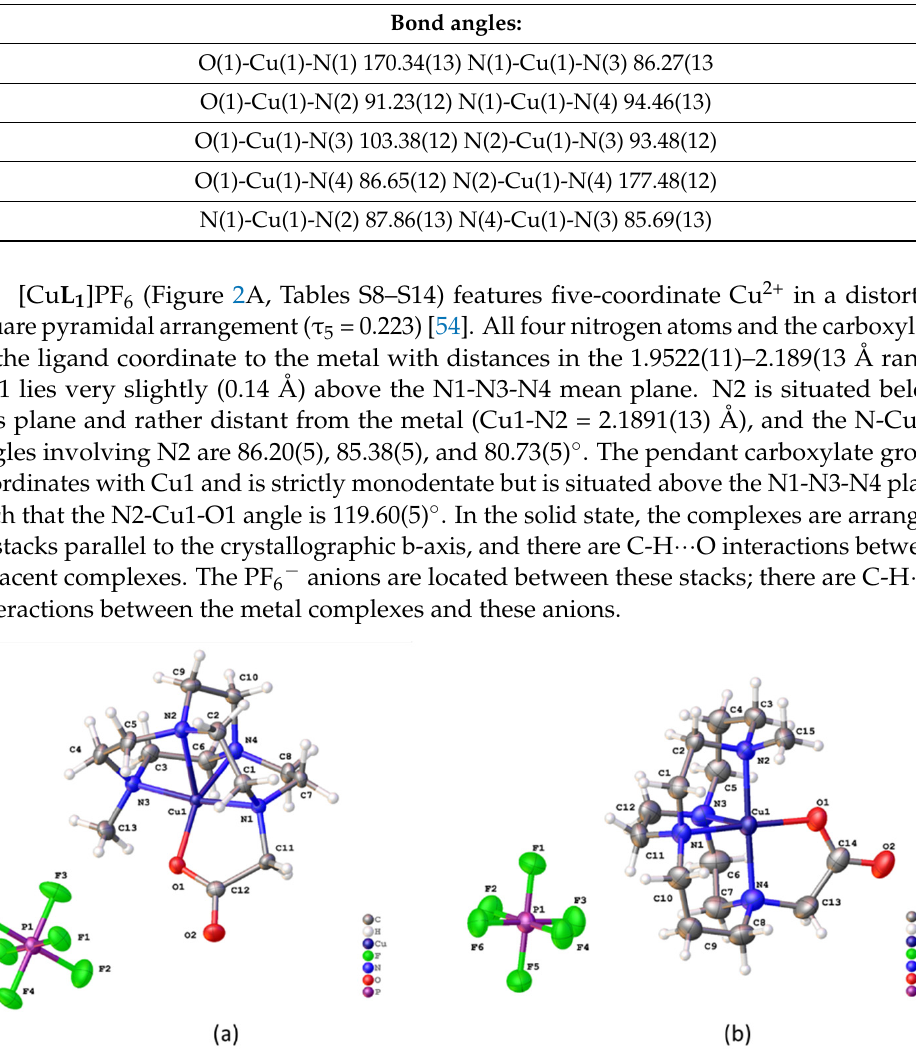
Figure 2. The asymmetric unit of ( a ) [Cu L 1 ]PF 6 and ( b ) [Cu L 2 ]PF 6 with atoms shown as 50% probability ellipsoids.